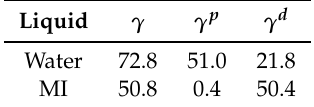
Table 2. Surface tensions for water and